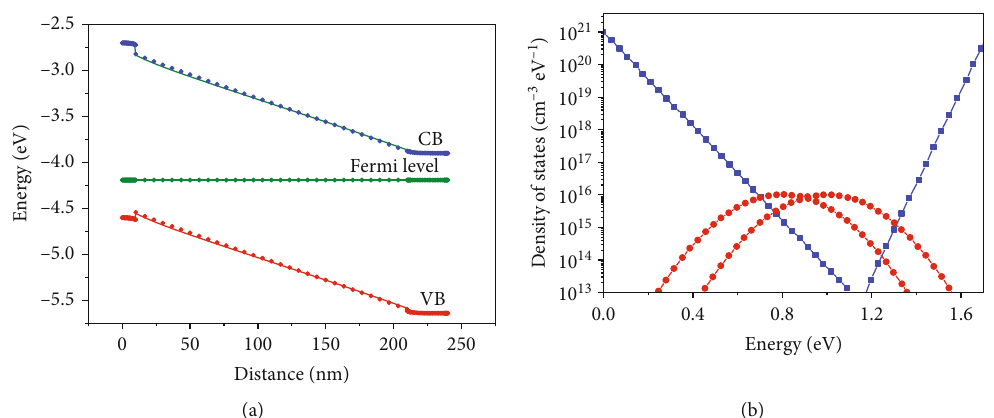
Figure 2: (a) Calculated equilibrium band diagram of the top p-i-n junction and (b) distribution of states in the gap of a-Si:H.